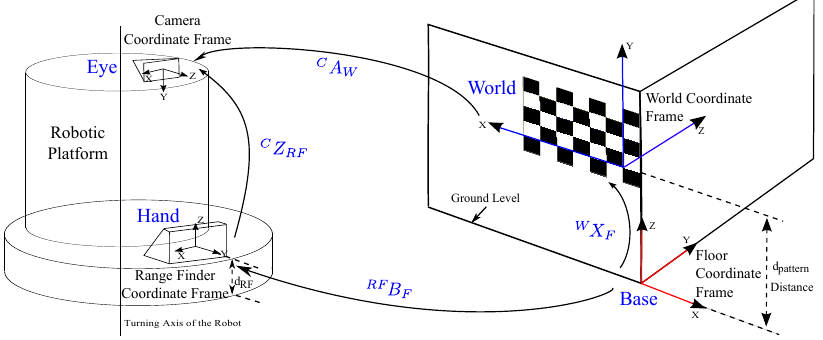
Figure 3. The calibration environment for configuration